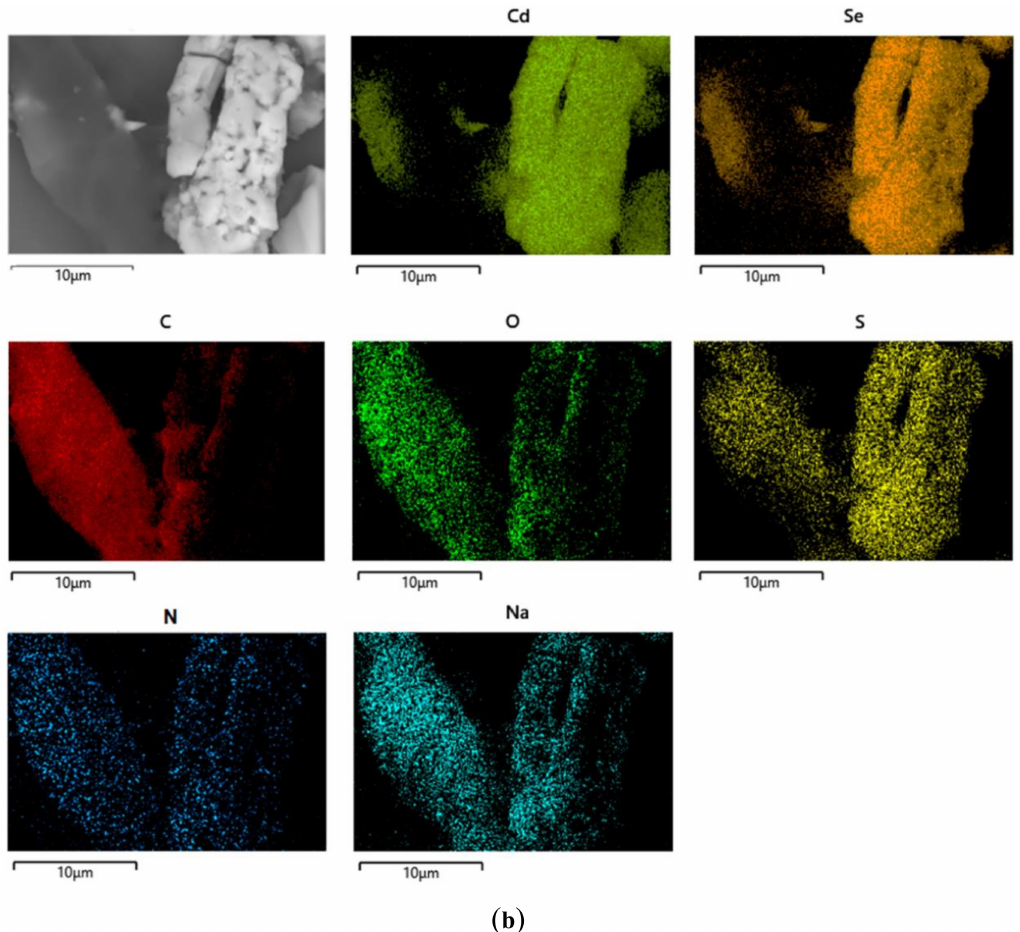
Figure 7. ( a ) EDX spectrum of CdSe–Cys QDs; ( b ): SEM micrograph with EDX mapping pattern